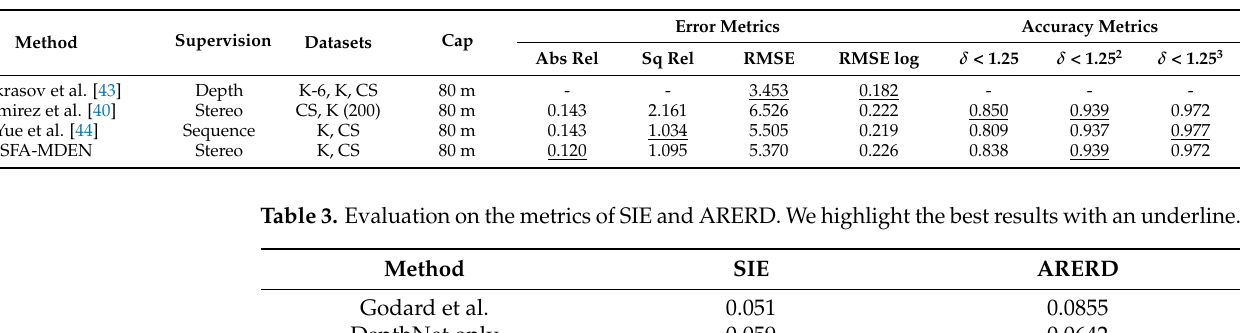
Figure 4. Qualitative samples on the Eigen split of KITTI. ( a ) The input RGB images, ( b ) ground truth depth maps, ( c ) outputs of Godard et al. [31], ( d ) outputs of DepthNet, ( e ) outputs of the proposed SFA-MDEN. Our method achieves the plausible estimation quality on the surfaces and boundaries. Table 2. Comparison between monocular depth estimation methods with semantic auxiliary and SFA-MDEN. For datasets, K = KITTI, CS = Cityscapes, K-6 = KITTI-6, and K (200) denotes the 200 images Ramirez et al. [50] used in KITTI. We highlight the best results with an underline. Nekrasov et al. [43] only reported the evaluation metrics of RMSE and RMSE log. Method